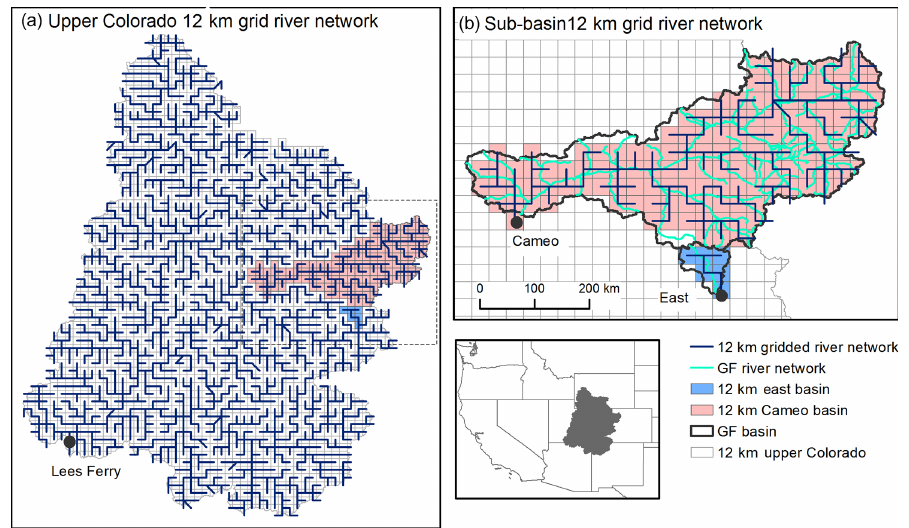
Figure 10. 1 / 8 ◦ ( ∼ 12km) grid-based river network for the upper Colorado River basin (a) and two sub-basins inside the upper Colorado– Colorado River near Cameo and East River at Almont (b) . HRUs for each GF river segment are not shown for clarity in (b) .